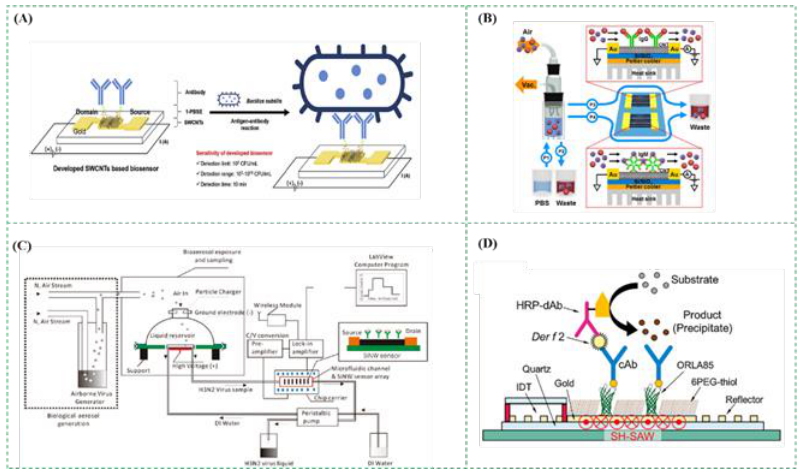
Figure 8. ( A ) The electrochemical biosensor for detection of the bioaerosols containing Bacillus subtilis . Reprinted with permission from ref. [105]. Copyright 2017 Elsevier B.V. ( B ) The FET biosensor for detection of the bioaerosols containing Alternaria alternate and Aspergillus niger . Reprinted with permission from ref. [106]. Copyright 2016 American Chemical Society. ( C ) The FET biosensor on microfluidic chips for detection of the bioaerosols containing influenza H3N2 viruses. Reprinted with permission from ref. [107]. Copyright 2011 American Chemical Society. ( D ) The SAW biosensor for detection of the bioaerosols containing house dust mite allergens. Reprinted with permission from ref. [115]. Copyright 2019 Elsevier B.V.